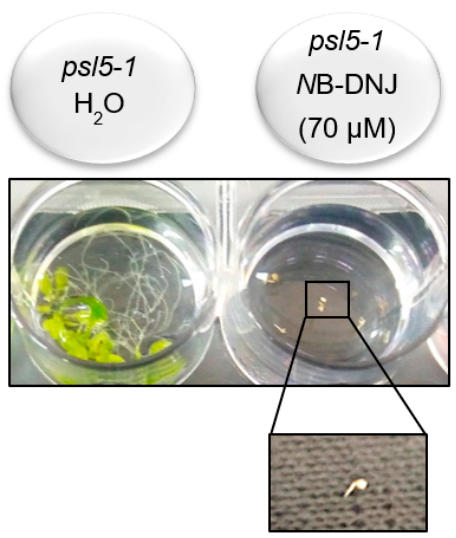
Figure 5. At psl5-1 and N B-DNJ. Arabidopsis thaliana psl5-1 seedlings show impaired growth in presence